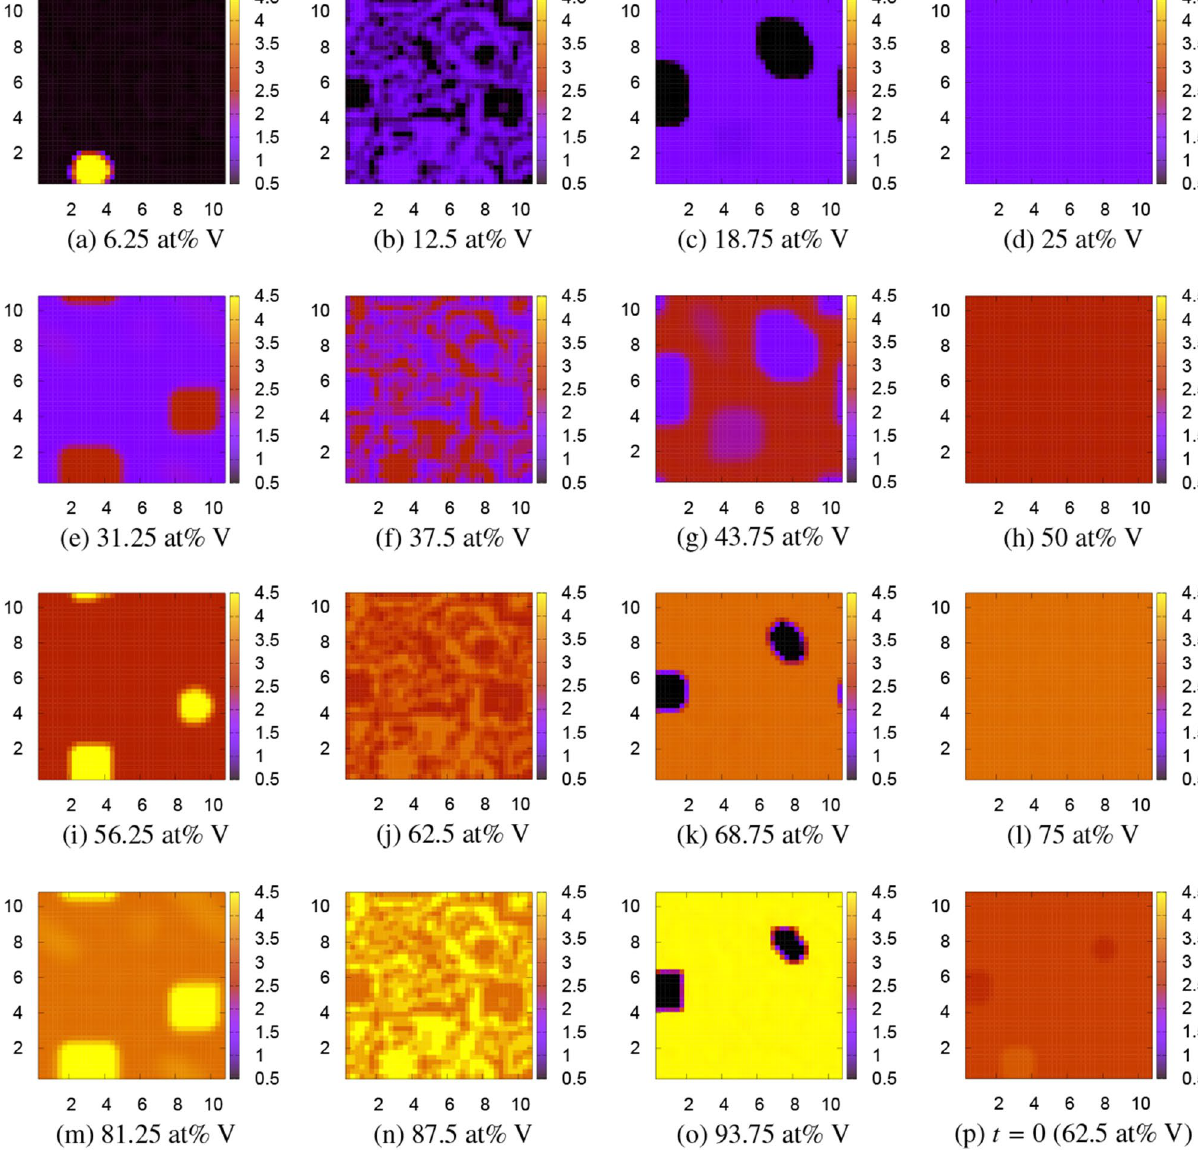
n V n alloy obtained by the first FPPF simulation, FPPF1, using the original − 0 for 62.5 at% =